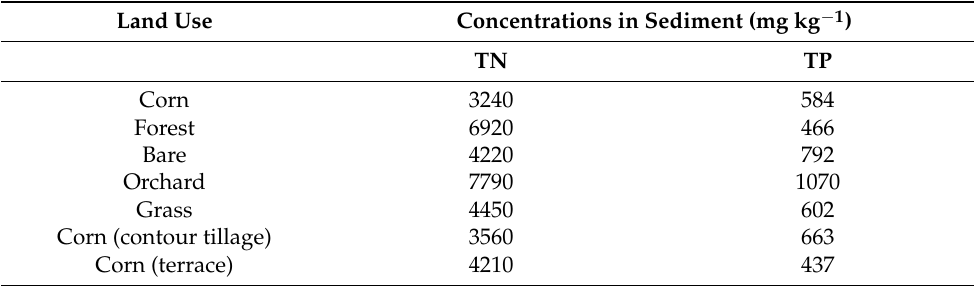
Table 2. TN and TP concentrations in the sediments from different plots (data are from [22]).